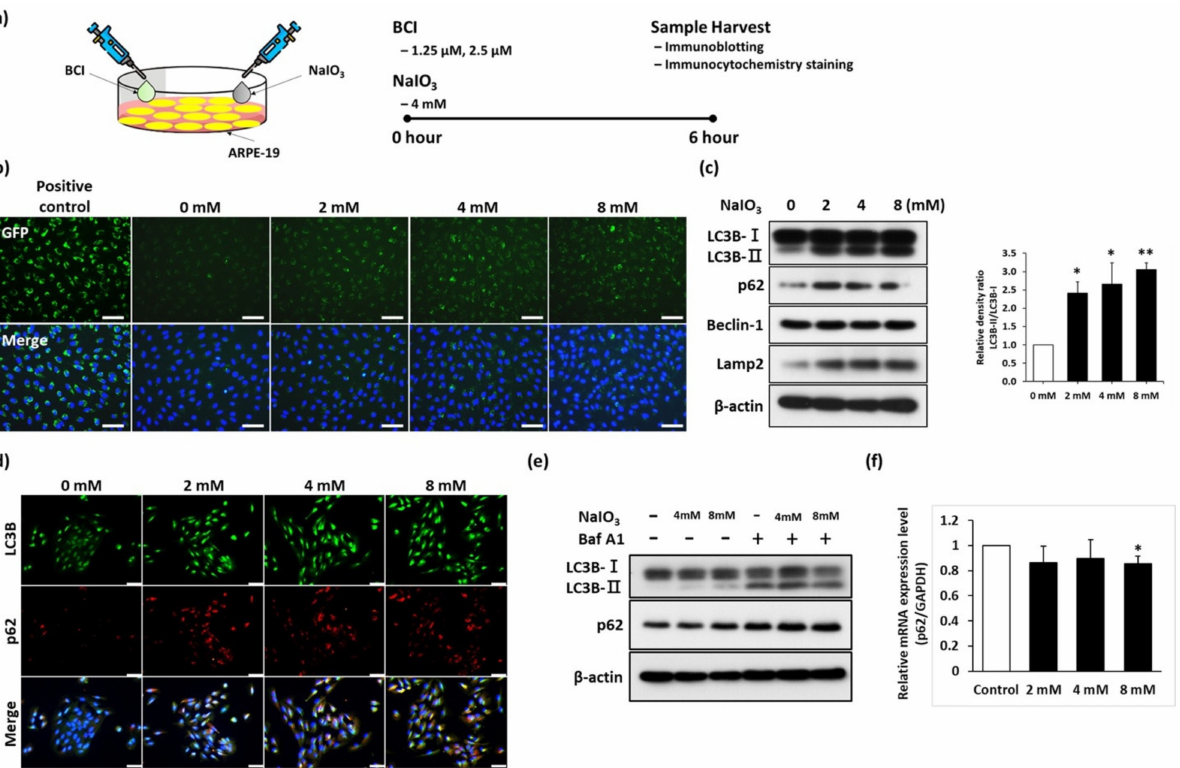
Figure 1. Sodium iodate disrupted the autophagy flux in ARPE-19 cells. ( a ) Schematic showing the protocol of in vitro NaIO 3 treatment on ARPE-19 cells. ( b ) Autophagic vesicles in ARPE-19 cells with NaIO 3 treatment were detected using a autophagic detection kit. Scale bar = 100 µ m. ( c ) Representative blots analysis of autophagy relative protein expression after NaIO 3 treatment. Quantitative analysis of immunoblotting. ( d ) Immunocytochemistry staining of LC3B and p62 after NaIO 3 treatment in ARPE-19 cells. Nuclei were stained with DAPI. Scale bar = 50 µ m. ( e ) Representa- tive blots analysis of autophagic flux relative protein expression under Baf-A1 treatment. ( f ) Real-time quantitative PCR showed an mRNA level of p62; n = 3. Representative data from three independent experiments are shown. * p < 0.05 and ** p <